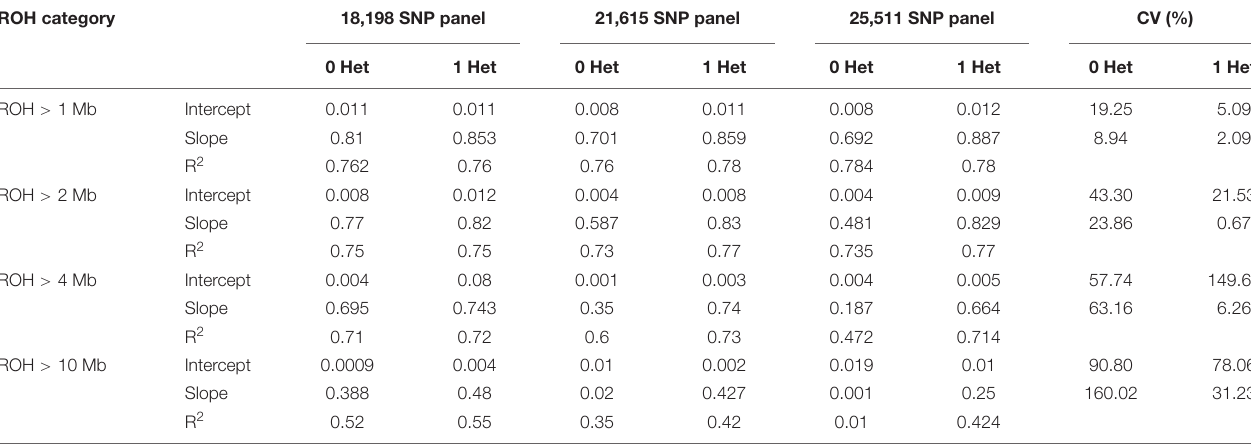
TABLE 1 | Regression of the kinship coefficient ( θ IBD ) and the genomic inbreeding estimated through ROH (F ROH ). ROH